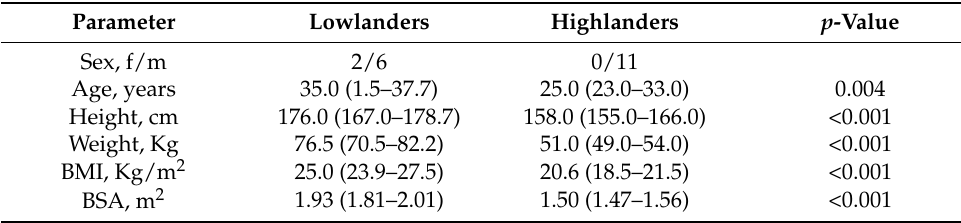
Table 1. Main anthropometric characteristics of participants. Parameter Lowlanders Highlanders